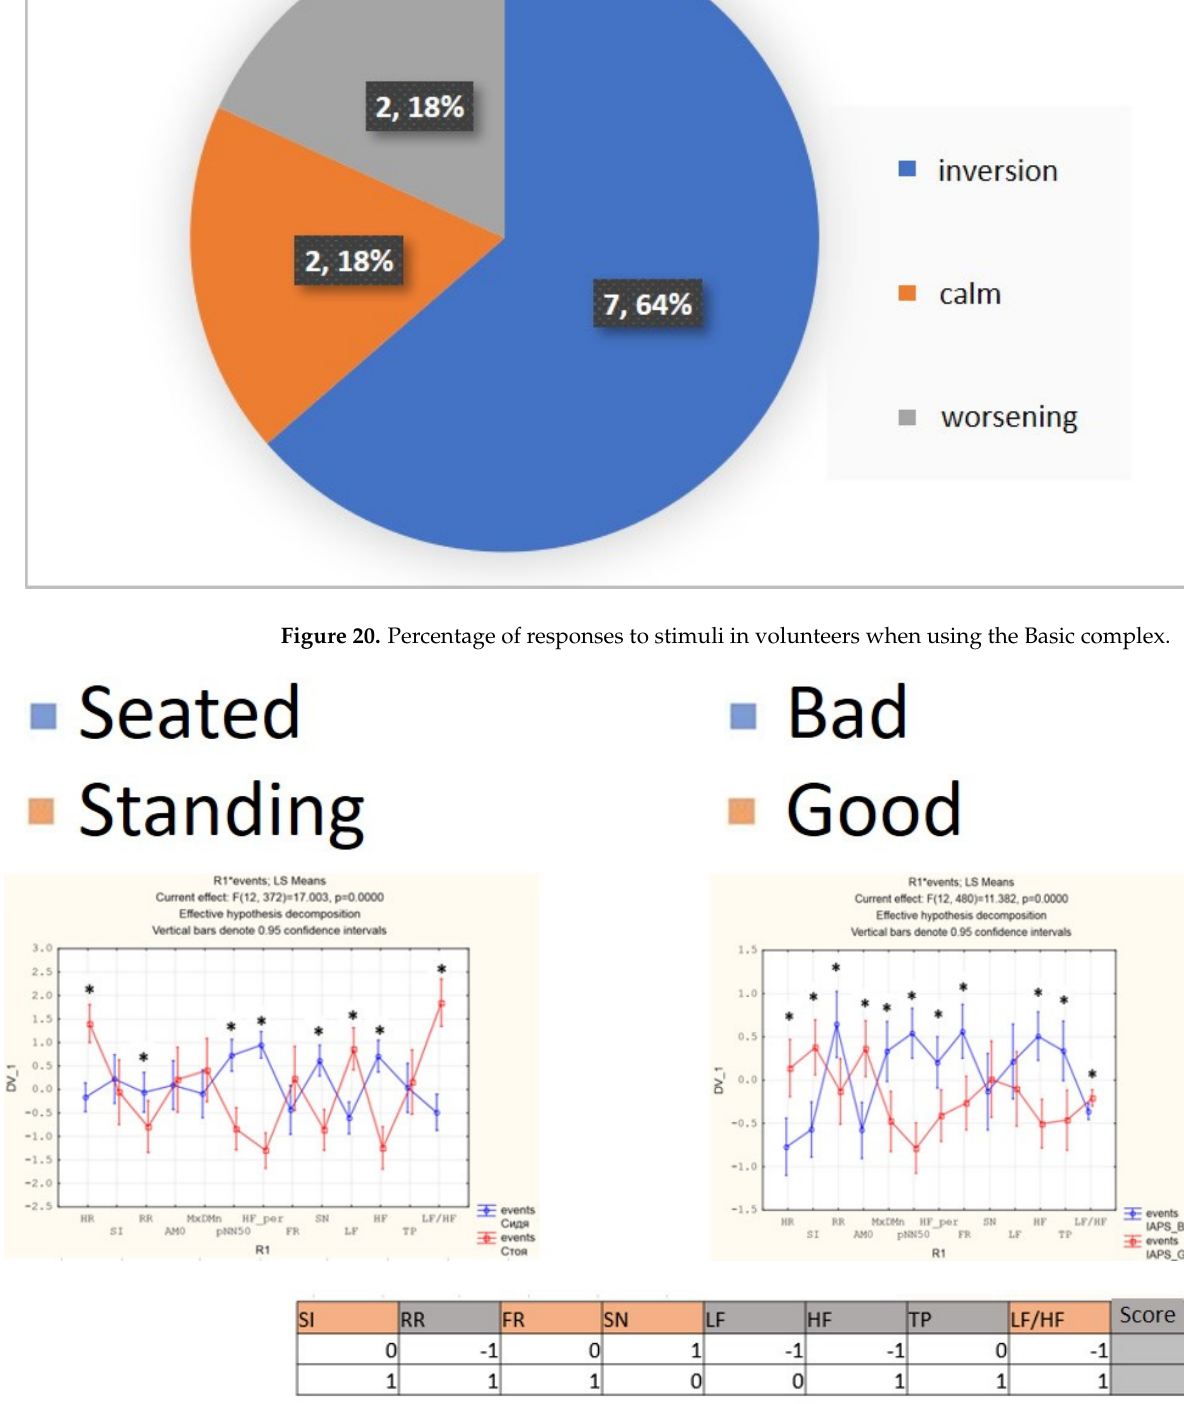
Figure 21. An example of inverse reaction of a test subject, the Basic complex.